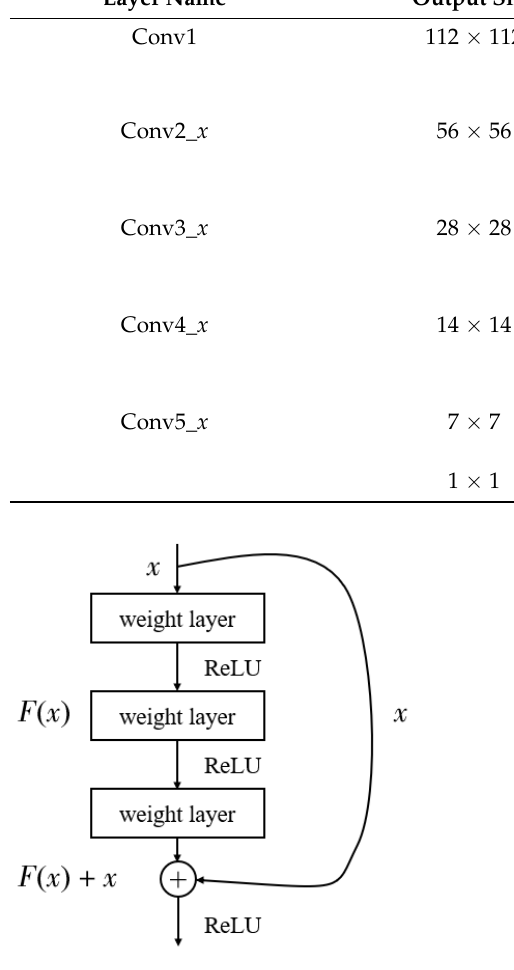
Table 2. The architecture of ResNet50.